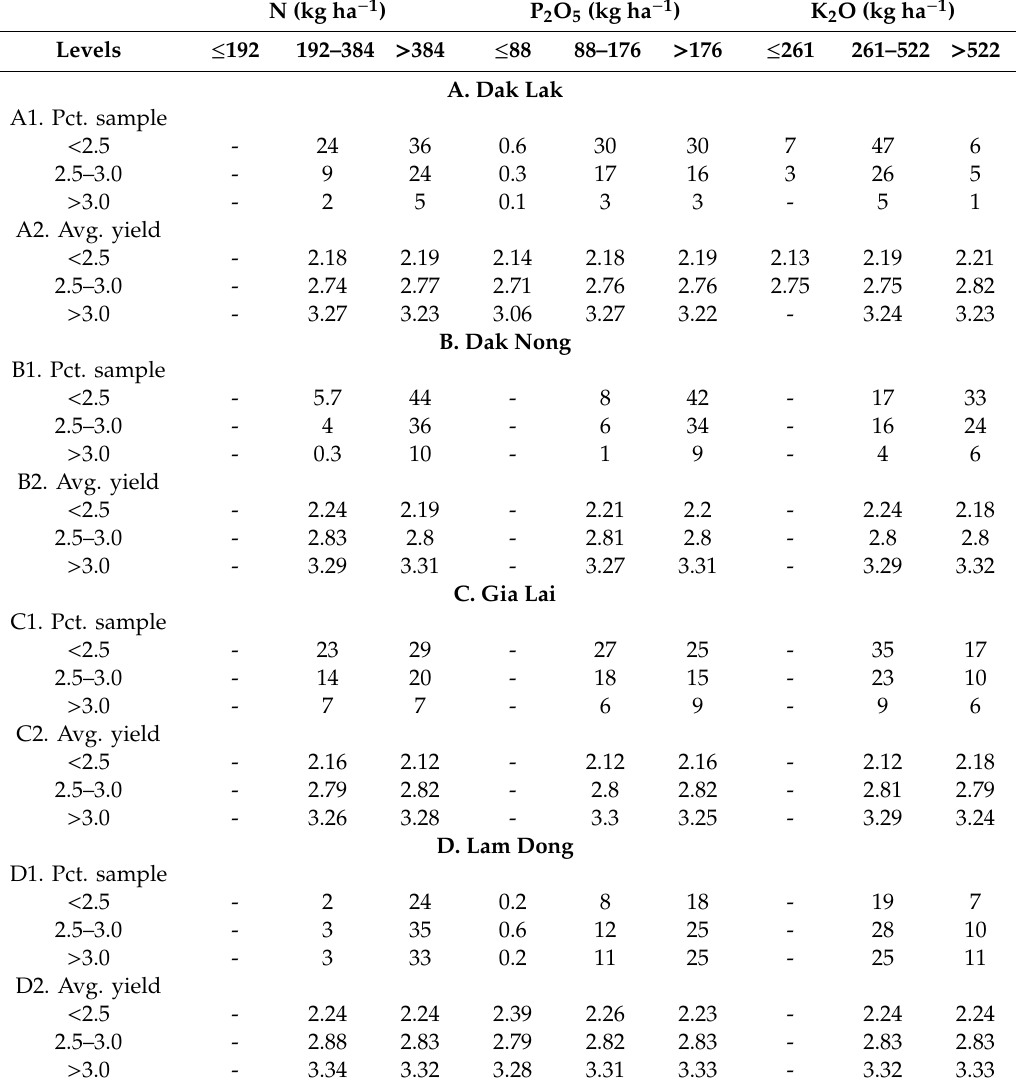
Table 8. Variations of Robusta co ff ee yields under di ff erent categories of N, P 2 O 5 and K 2 O rates in large-scale farms for each of the study provinces in Vietnam. Pct. sample: sample distribution from all the 2008–2017 dataset (expressed in %); Avg. yield: average co ff ee yield (ton ha − 1